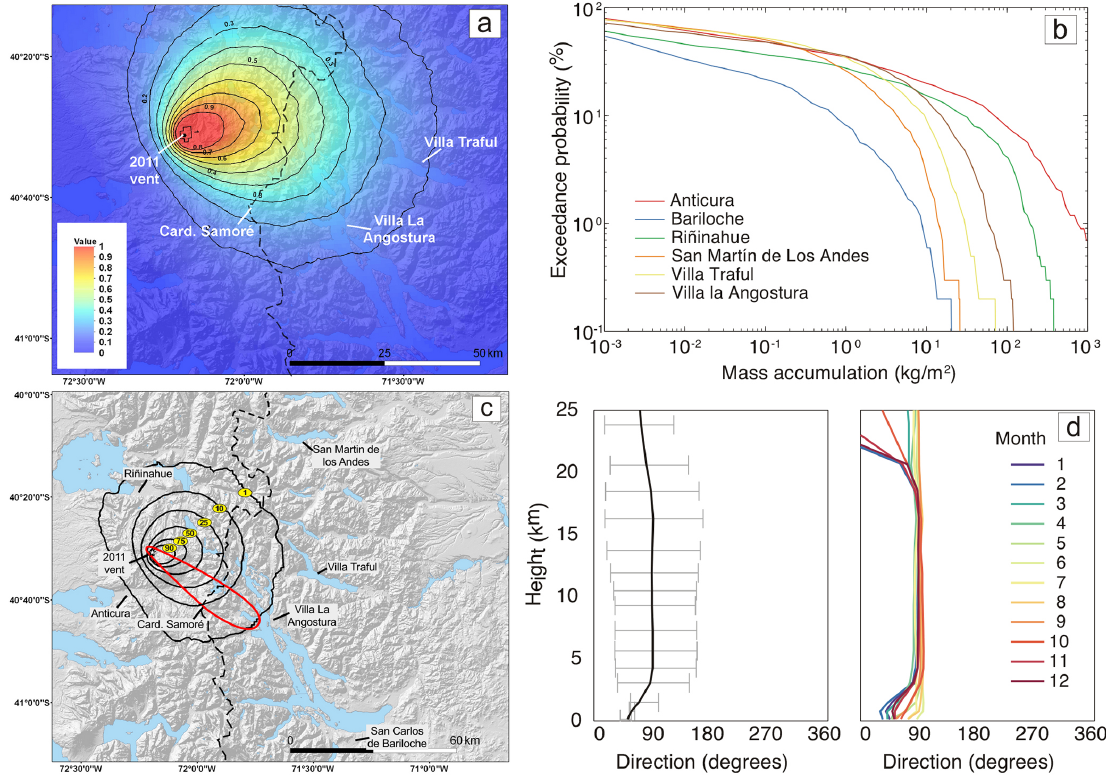
Figure 8. (a) Spatial distribution of the probability of reaching a tephra accumulation of 10kgm − 2 ; (b) hazard curves showing the exceeding probability for the towns of Anticura and Riñinahue in Chile and San Martin de Los Andes, Villa Traful, Villa La Angostura and Bariloche in Argentina; (c) location of the 100kgm − 2 isomass contours as inferred from the probabilistic modelling for probabilities of occurrence of 1, 10, 50 and 90% resulting from an eruption of similar intensity of the 2011 CC climactic phase (see also Table 8); the red isoline shows the 100kgm − 2 isomass line for the 2011 CC climactic phase as compiled by Bonadonna et al. (2015a) as a comparison; (d) statistical analysis of the wind direction based on the NOAA NCEP/NCAR Reanalysis database for the period 2000–2015 (left plots shows the median value and standard deviation, while the right plot shows the median value for each month; see main text for more